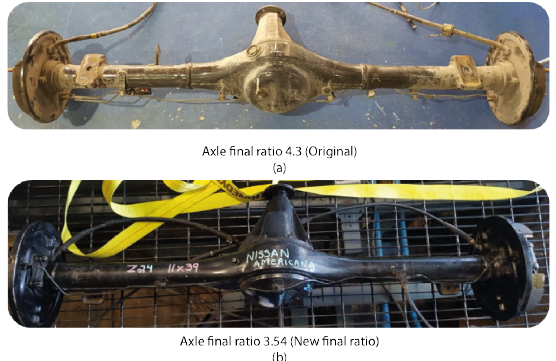
Figure 4. Axles with ( a ) original final ratio (4.3), ( b ) new final ratio